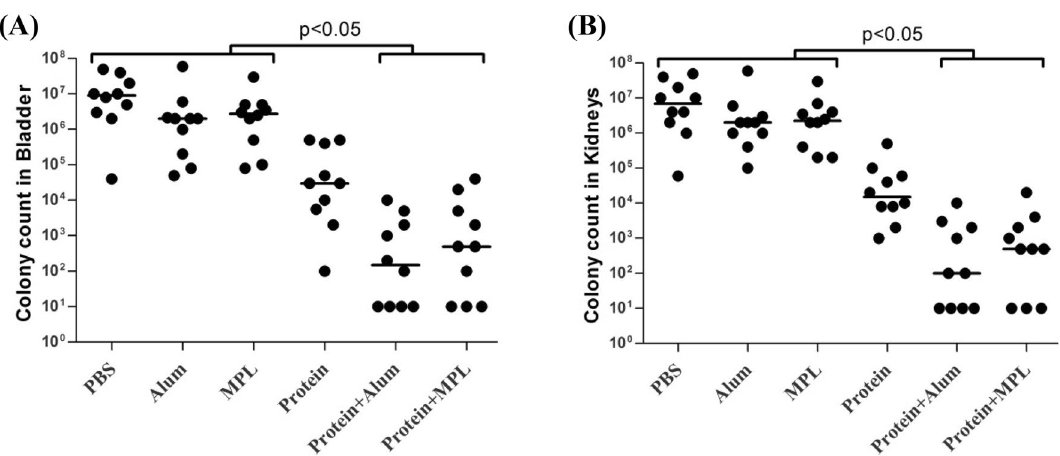
Figure 6. Protective efficacy of the vaccine combinations in a challenge model. Mice were immunized with vaccine formulations and challenged with P. aeruginosa strain by transurethral route. Thereafter, the bacterial burdens in the ( A ) bladder and ( B ) kidneys of the mice were counted after 2 days. Symbols show the bacterial count of each mice group with median of the colonization number. Statistical significance of the differences between mice groups is shown by brackets with P